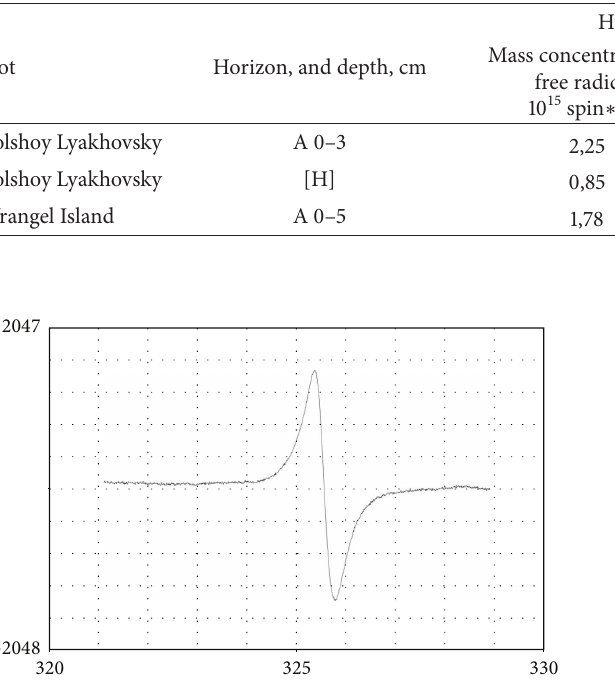
Table 5: Paramagnetic features of HAs and FAs.